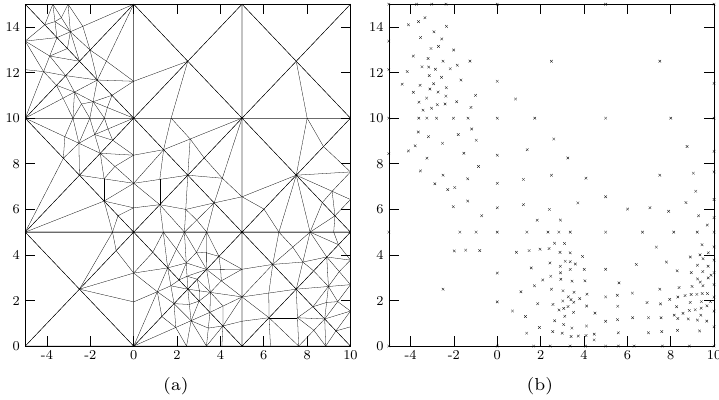
Figure 4. The illustration of minimization results of the Branin function: simplicial covering of the feasible region after termination with Δ = 0 . 05 d and points where function values were computed after termination with Δ = 0 . 03